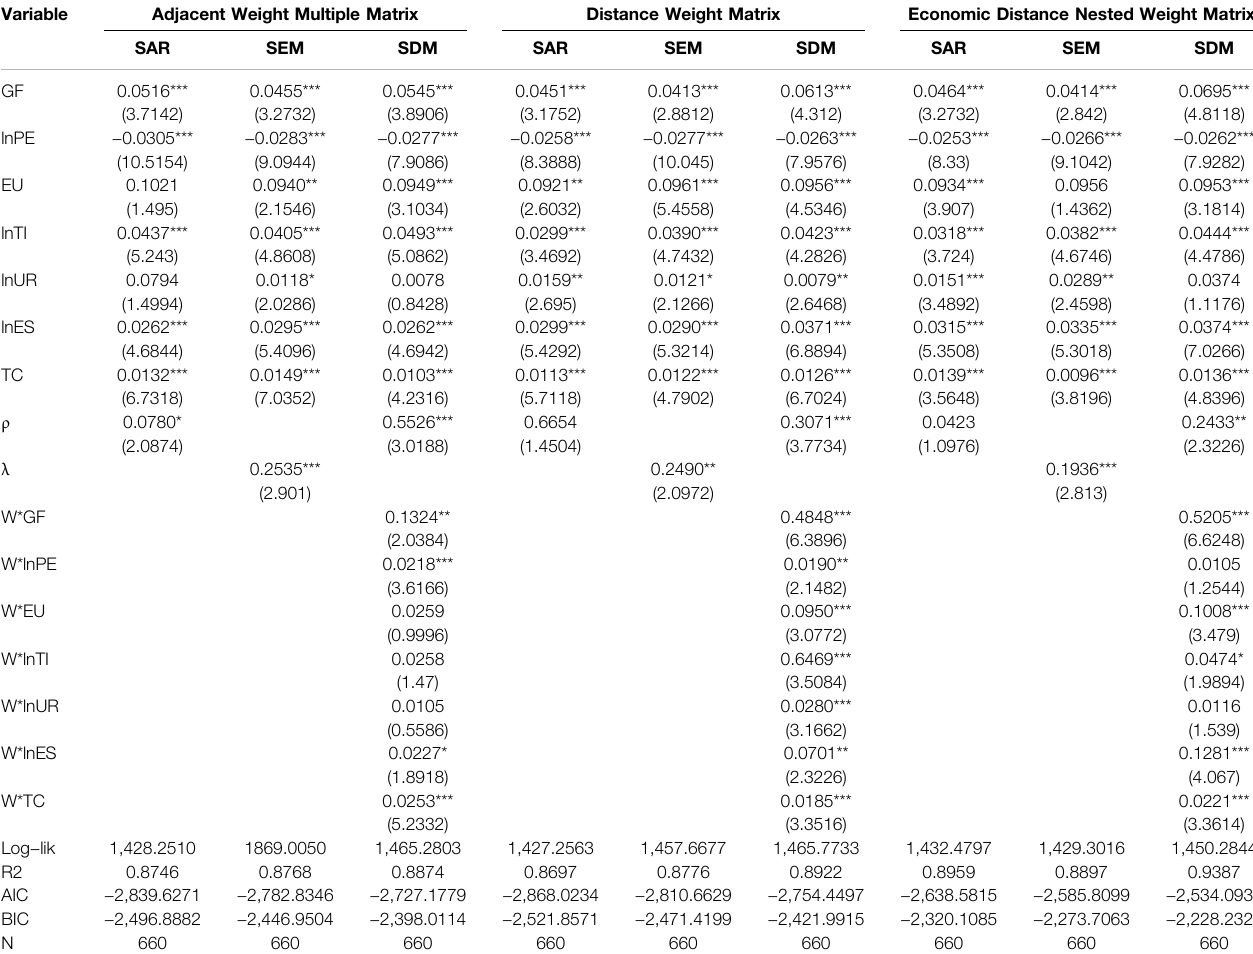
TABLE 4 | Estimation results of the spatial measurement model under the three weight